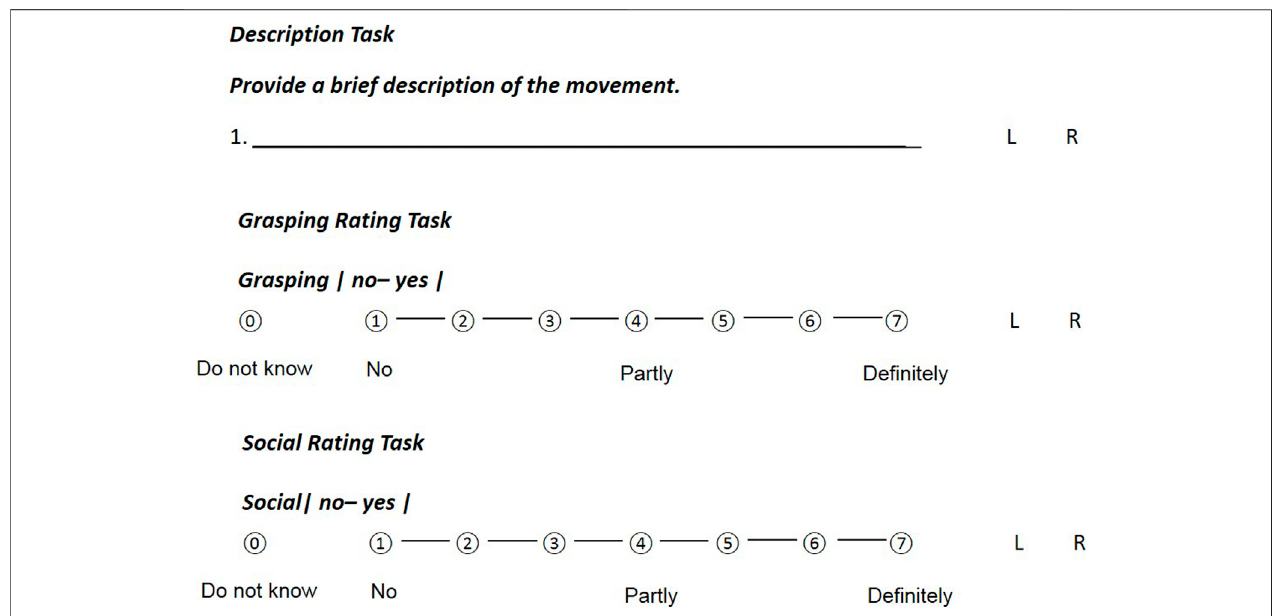
FIGURE 2 | Examples of the three different questionnaire tasks.